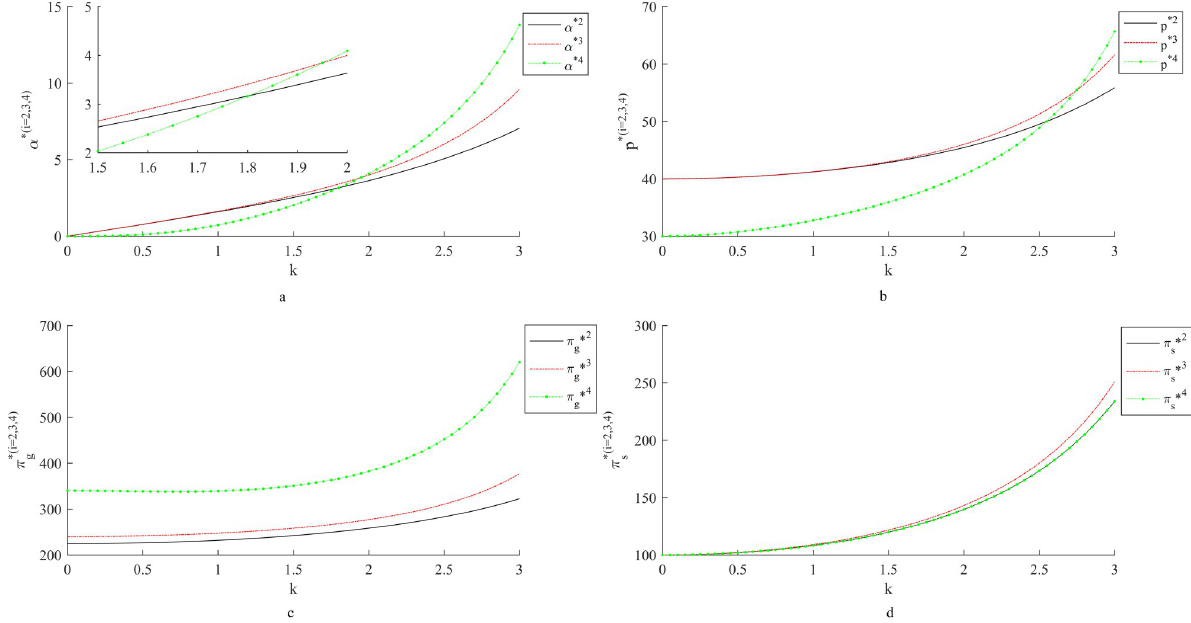
Fig 1. Influence of k on fresh-keeping decisions and